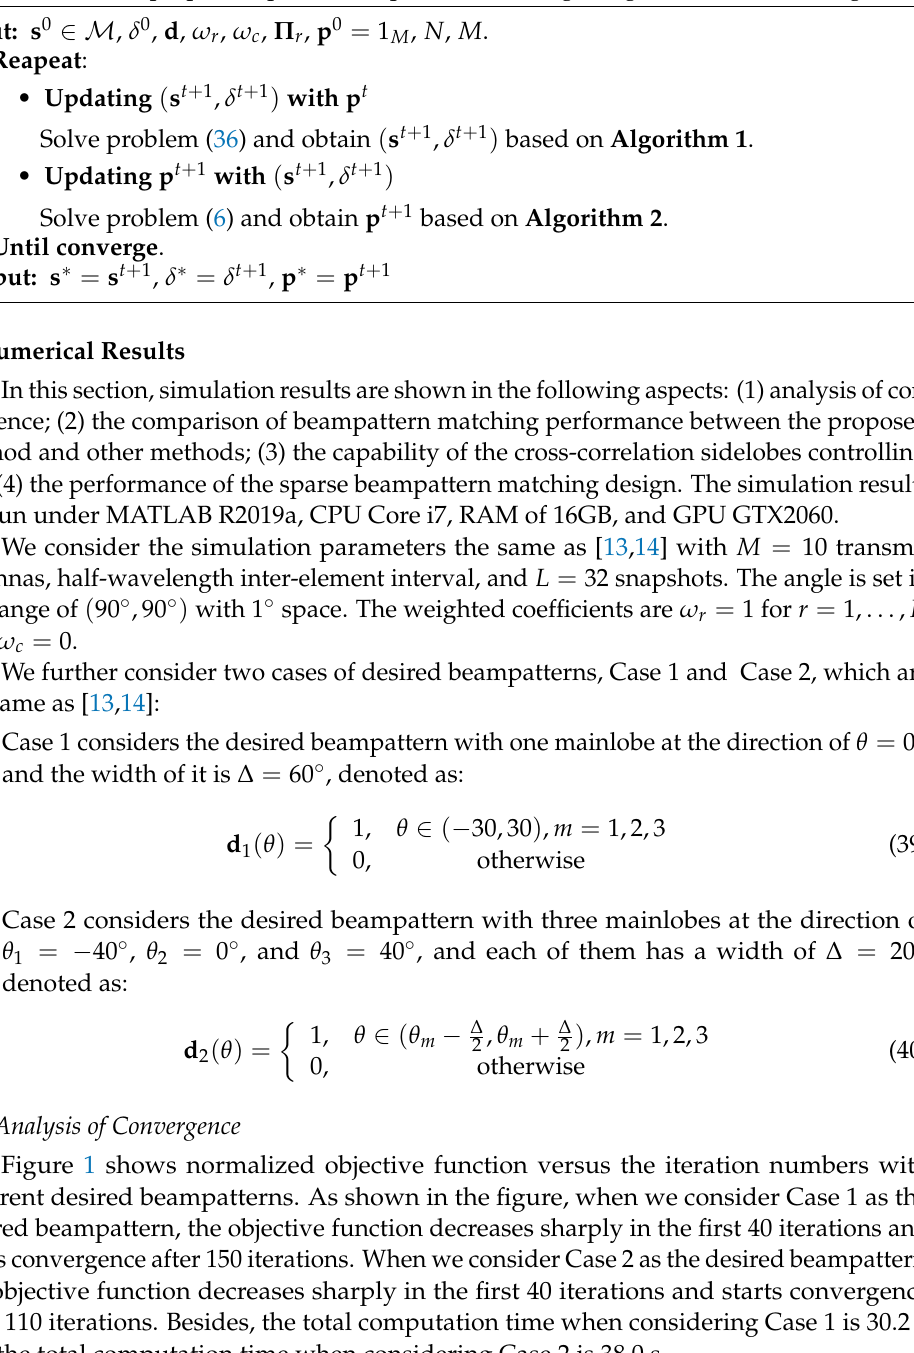
Algorithm 3 : The proposed sparse beampattern matching design method for solving